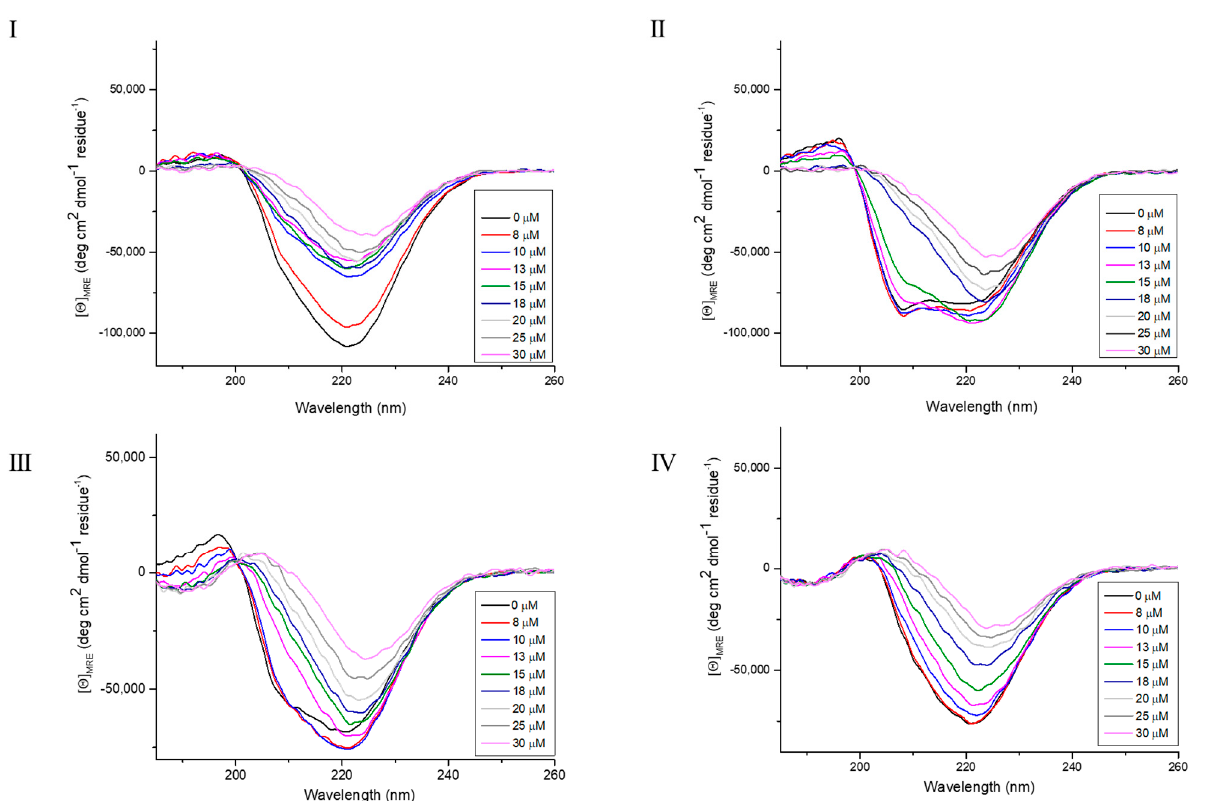
Figure 7. Far UV CD spectra of 10 µM OVA solutions in the presence of increasing concentrations of Zr-K 1:2 (from 0 to 30 µM) in the absence of surfactants, ( I ) as well as in the presence of 0.5 wt% SDS ( II ), 0.5 wt% Zw3-12 ( III ), and 0.5 wt% CHAPS ( IV ). All samples were buffered at pH 7.4 by a 10 mM sodium phosphate buffer and kept at 25 ± 0.1 °C during measurements.